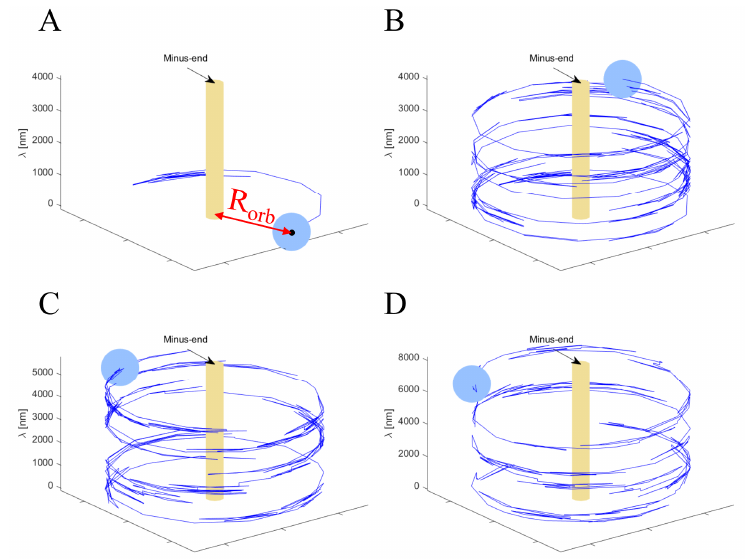
Figure 6. Traces of selected simulated trajectories. The light-blue sphere represents the NP ( R = 20 nm), the blue trailing lines represent the trajectory, and the yellow cylinder represents the MT. Note that while the MT and NP radii are drawn to scale, the MT length is not. ( A ) Initial trace of a single motor trajectory. The red arrow marks the distance between the MT and NP centers, R orb . ( B – D ) Traces of selected trajectories of an NP with N m = 1, 3, and 13 motors,